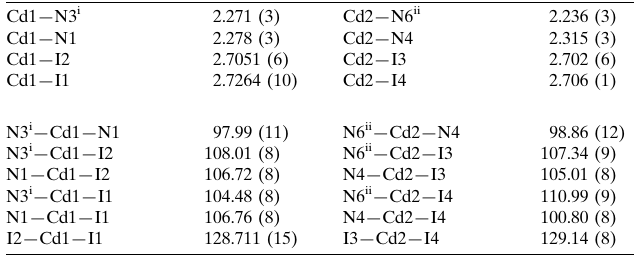
Selected geometric parameters (A˚ , (cid:2) ).